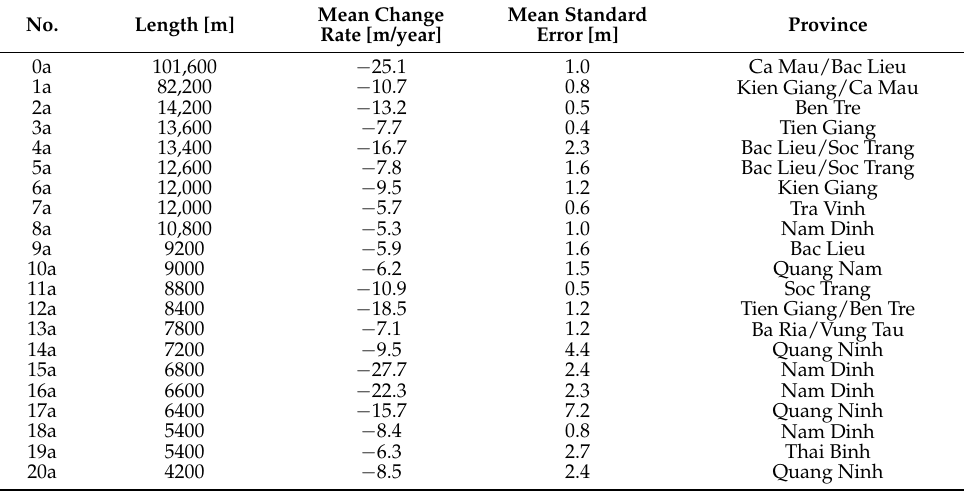
Table 5. Erosion hotspots in Vietnam from 1986 to